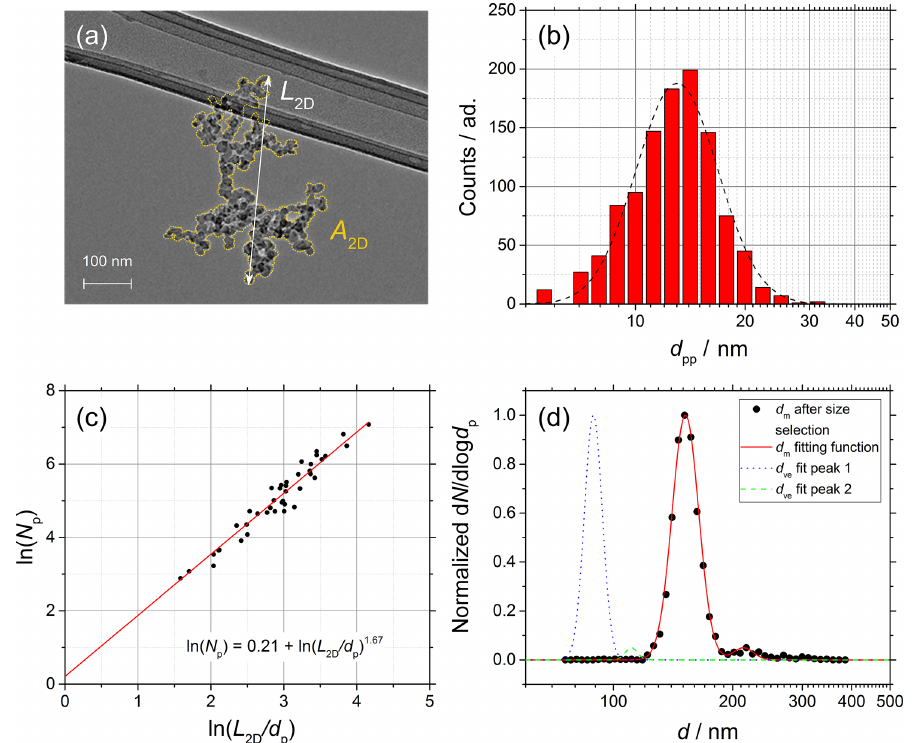
Figure 5. Soot sampled from the turbulent jet flame supplied with liquid kerosene at 70mm HAB. (a) TEM picture of a soot aggregate showing L 2D and A 2D . (b) d pp size distribution (red bars) and lognormal fit (dashed black line), d pp = 13 . 0nm (mass equivalent d pp = 14 . 1nm). (c) ln (N pp ) vs. ln (L 2D /d pp ) plot from which D f is obtained (42 projections). (d) Normalized SMPS data and d m fit after size selection at 150nm (black data points and dashed red line) and morphology-corrected d ve calculated using Eq. (11) showing a two-mode fit from Eq. (12) (dotted blue and dashed green